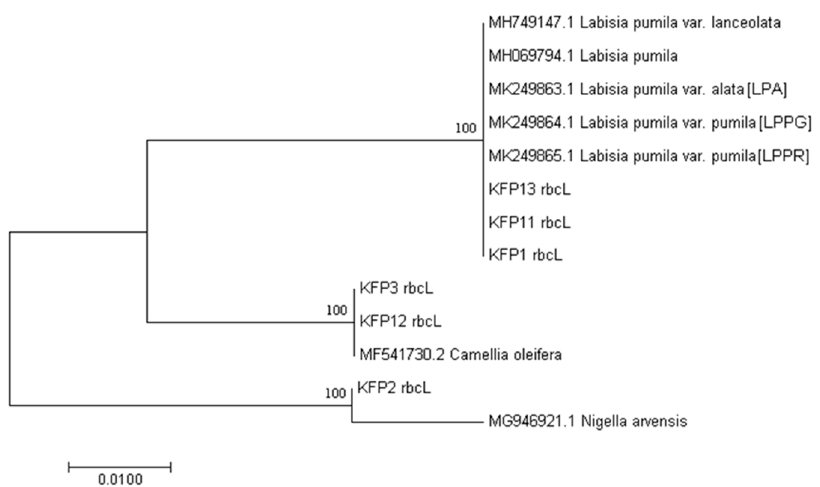
Figure 4. Neighbor-joining (NJ) tree of L. pumila HMP rbc L trimmed sequences compared to reference sequences generated in this work (MK249863.1, MK249864.1, and MK249865.1) and other DNA reference barcodes retrieved from GenBank (MH749147.1 and MH069794.1). KFP: Kacip Fatimah product. Numbers on the nodes of each branch are the bootstrap values for 1000 replicates.